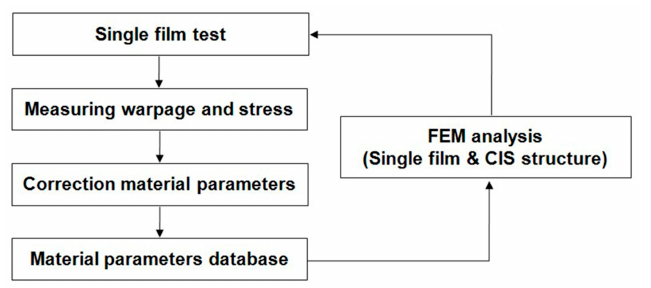
Figure 6. Flowchart for correction of the material parameters.